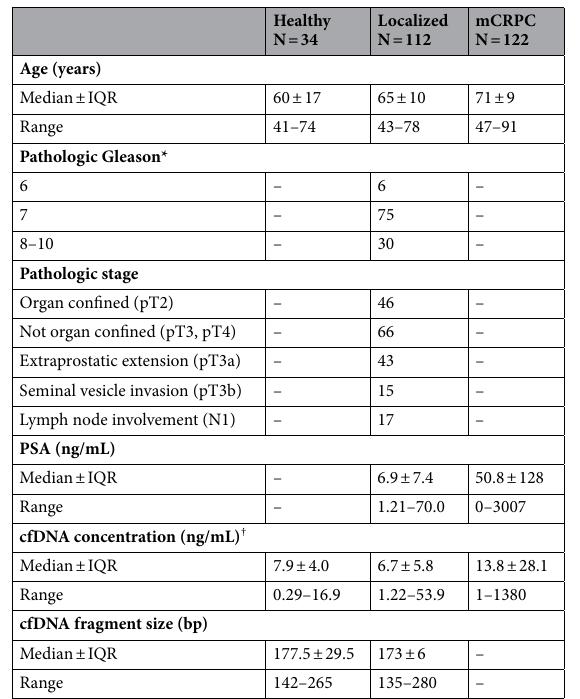
Table 1. Clinical characteristics of individuals included in the study at baseline. *One man with unknown data in the cohort. † Concentration data collected on a subset of individuals (31 healthy, 45 localized, and 122